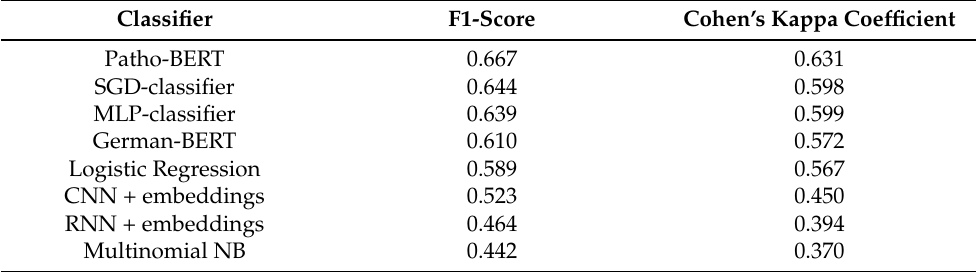
Table 4. Performance of different classification models, trained with the HDBSCAN cluster-set.